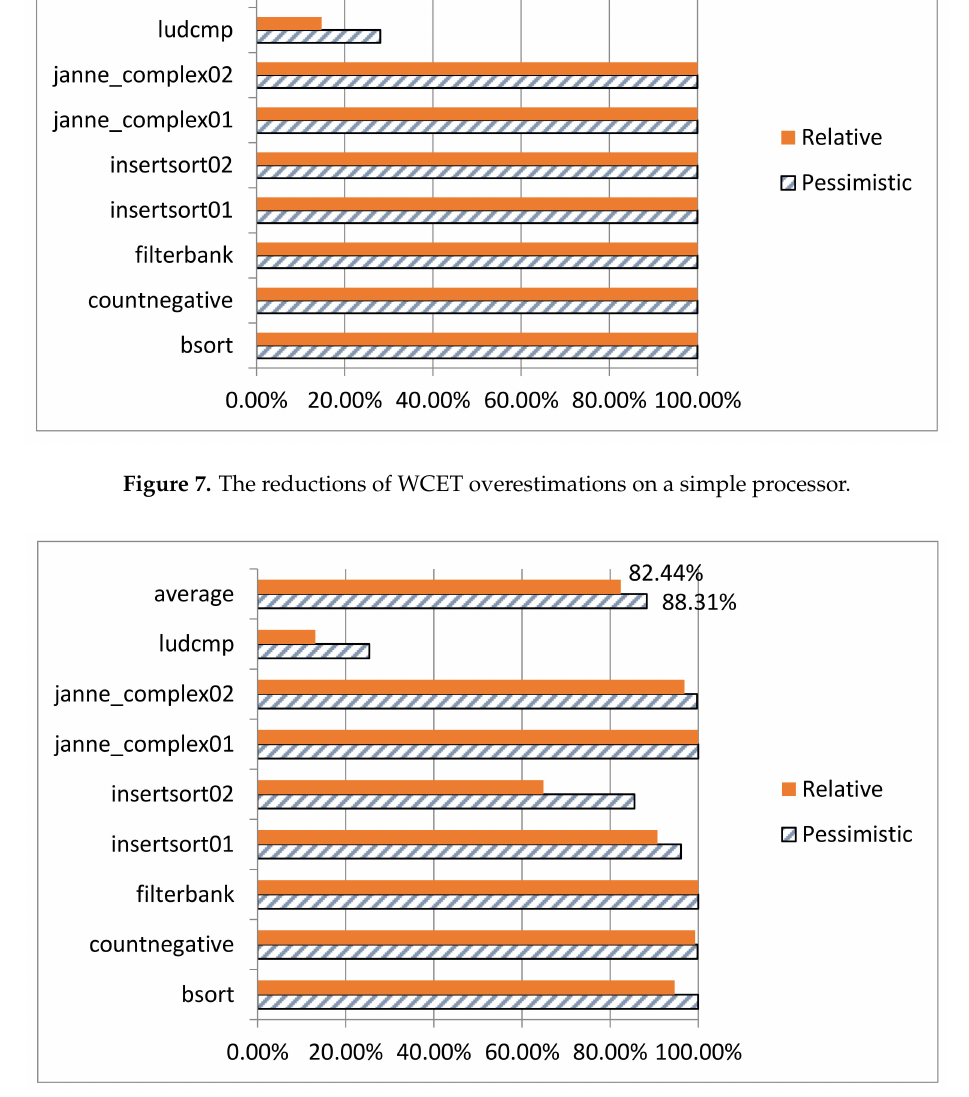
Figure 8. The reductions of WCET overestimations on a complex